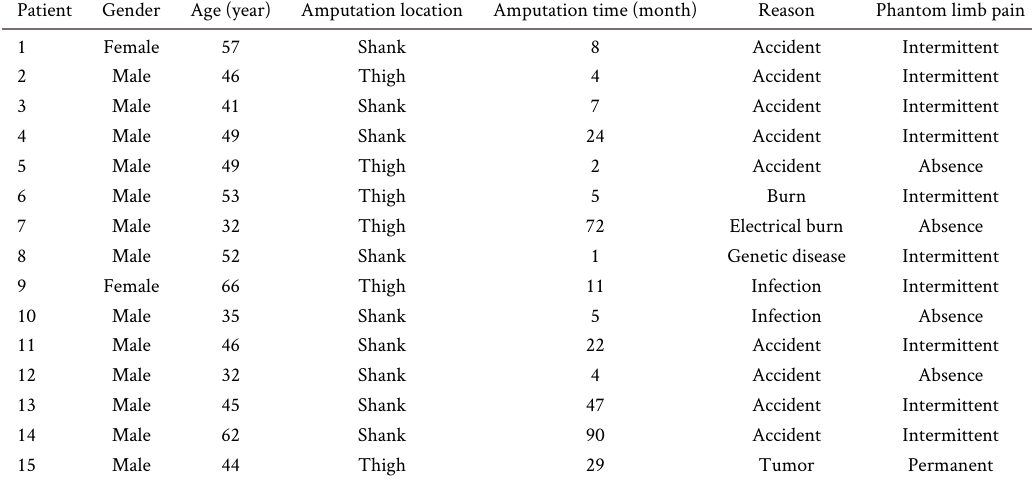
Table 1. The basic information of patients with